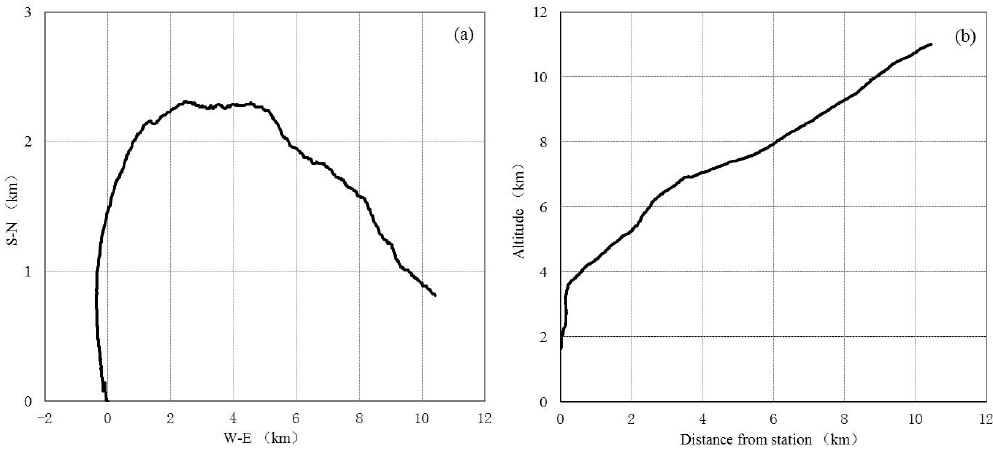
Figure 2. Balloon-borne sounding path, (a) surface projection; (b) distance and altitude from the station.